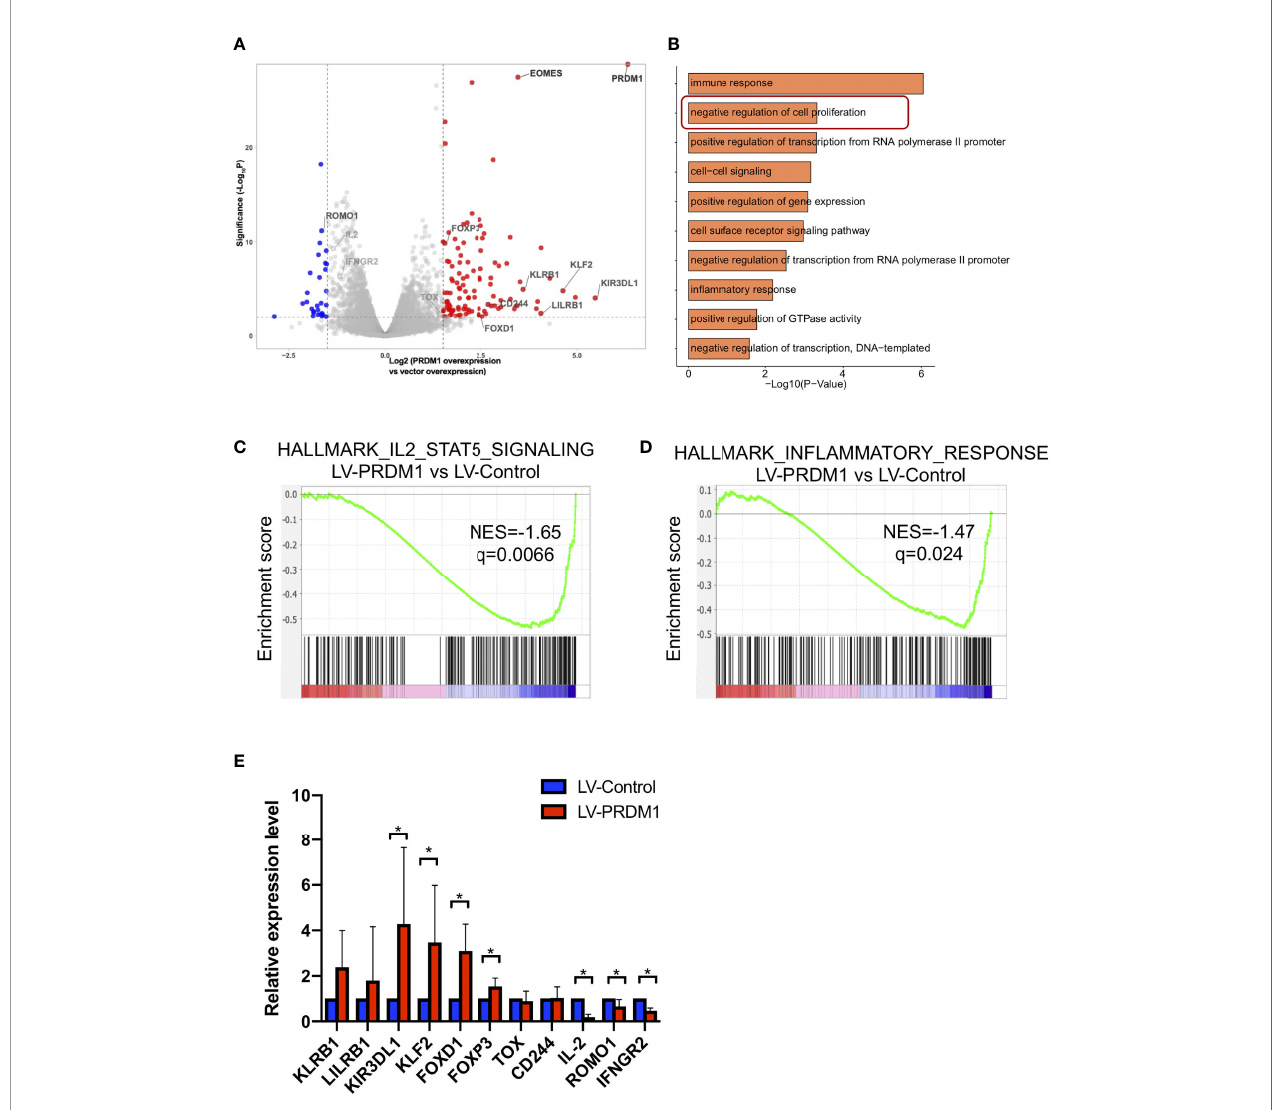
FIGURE 2 | T cell highly expressing PRDM1 exhibited tolerant transcription pro fi ling. (A) RNA-seq volcano plots comparing gene expression between PRDM1 - overexpressing T cells and control T cells (n = 3). FDR q-value < 0.01, |log 2 fold change| > 1.5. (B) Gene pathway enrichment analysis for the upregulated genes in PRDM1 -overexpressing T cells. (C, D) GSEA pathway enrichment plot in PRDM1 -overexpressing T cells versus control T cells. NESs and P values are shown for each gene set. P values were calculated by Kolmogorov-Smirnov test. (E) Quantitative real-time PCR was used to validate upregulated and downregulated genes in PRDM1 - overexpressing T cells detected by RNA-seq (n = 5). Wilcoxon rank sum test was performed to assess the signi fi cance of relative gene expression. *P <